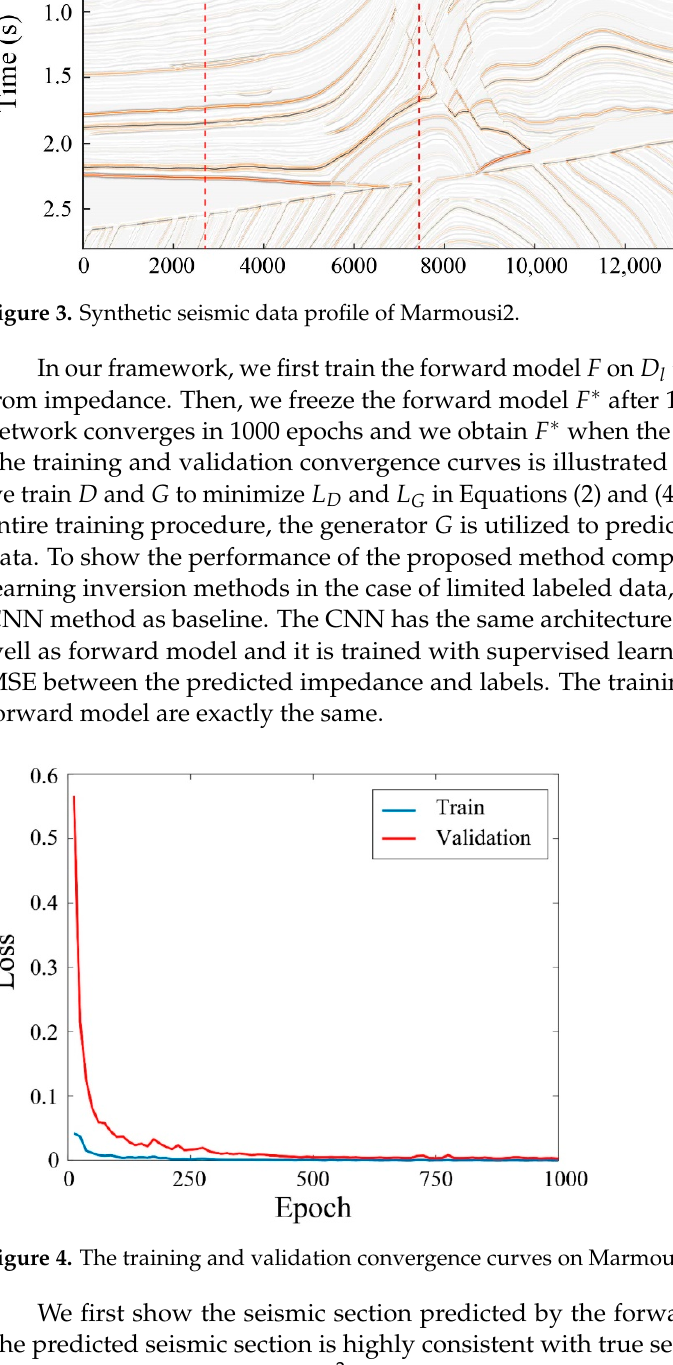
ficient (PCC) of being 0.9955 and MSE of being 9.544 × 10 (cid:2879)(cid:2874) , respectively. The impedance